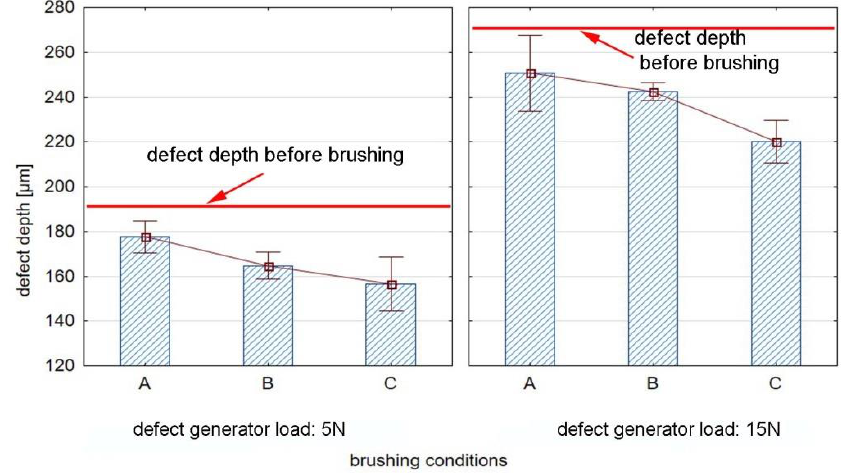
Figure 11. Effect of brushing conditions on defect depth for AZ91HP magnesium alloy.